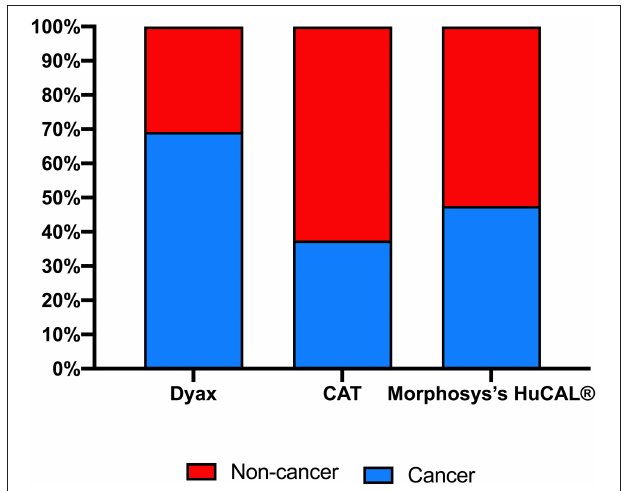
FIGURE 5 | Indications for antibodies isolated from various major company-owned libraries. Clinical domains (cancer vs. non-cancer) of the approved or in clinical trials antibody-derived phage